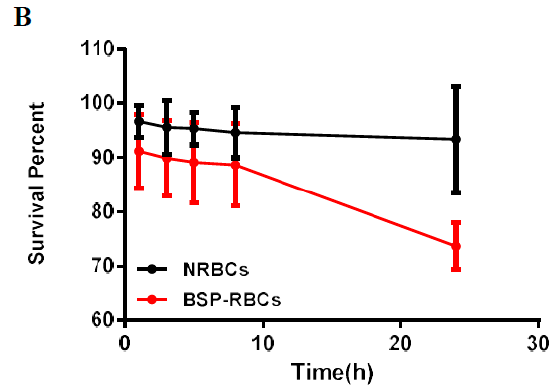
Figure 6. In vivo survival of NRBC and BSP-RBC. ( A ) Survival in 9 days; ( B ) Survival in the first 24 h. Data are represented as mean ± SD, three samples were used in each group.